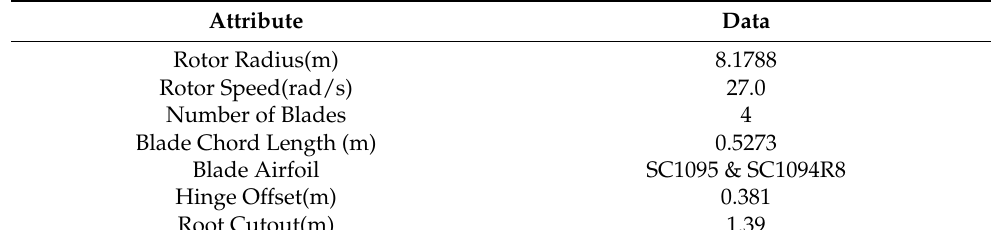
Table 1. Baseline helicopter attributes.